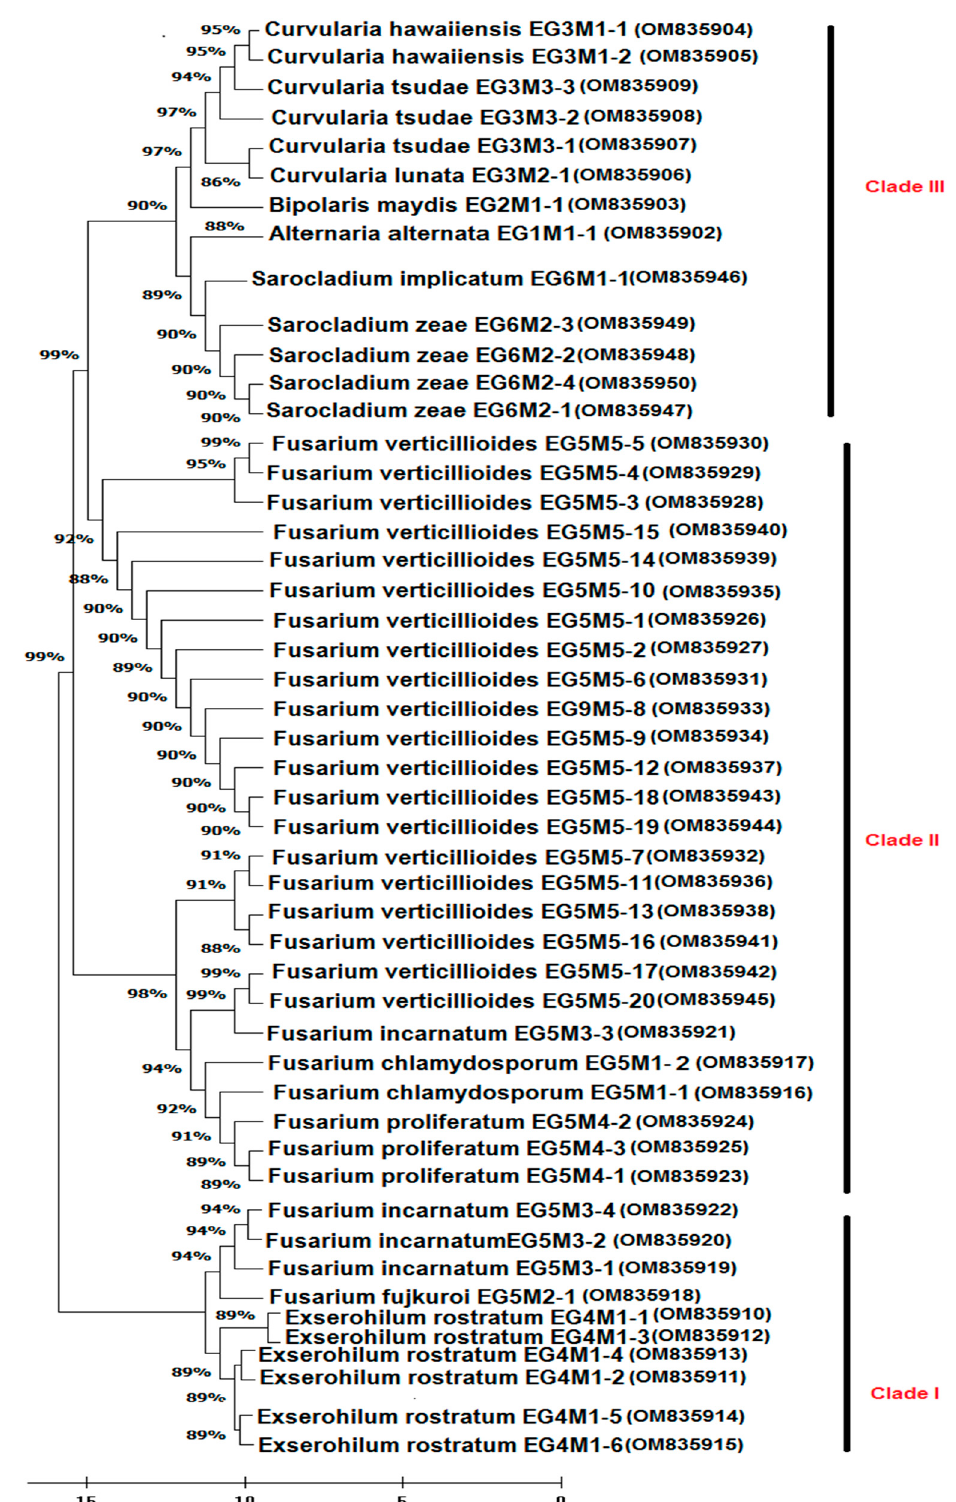
Figure 8. Phylogenetic tree of the seed-borne fungal species [scientific name, isolate code, (GenBank accession number)] isolated from maize grain samples in all 25 maize-cropping governorates of